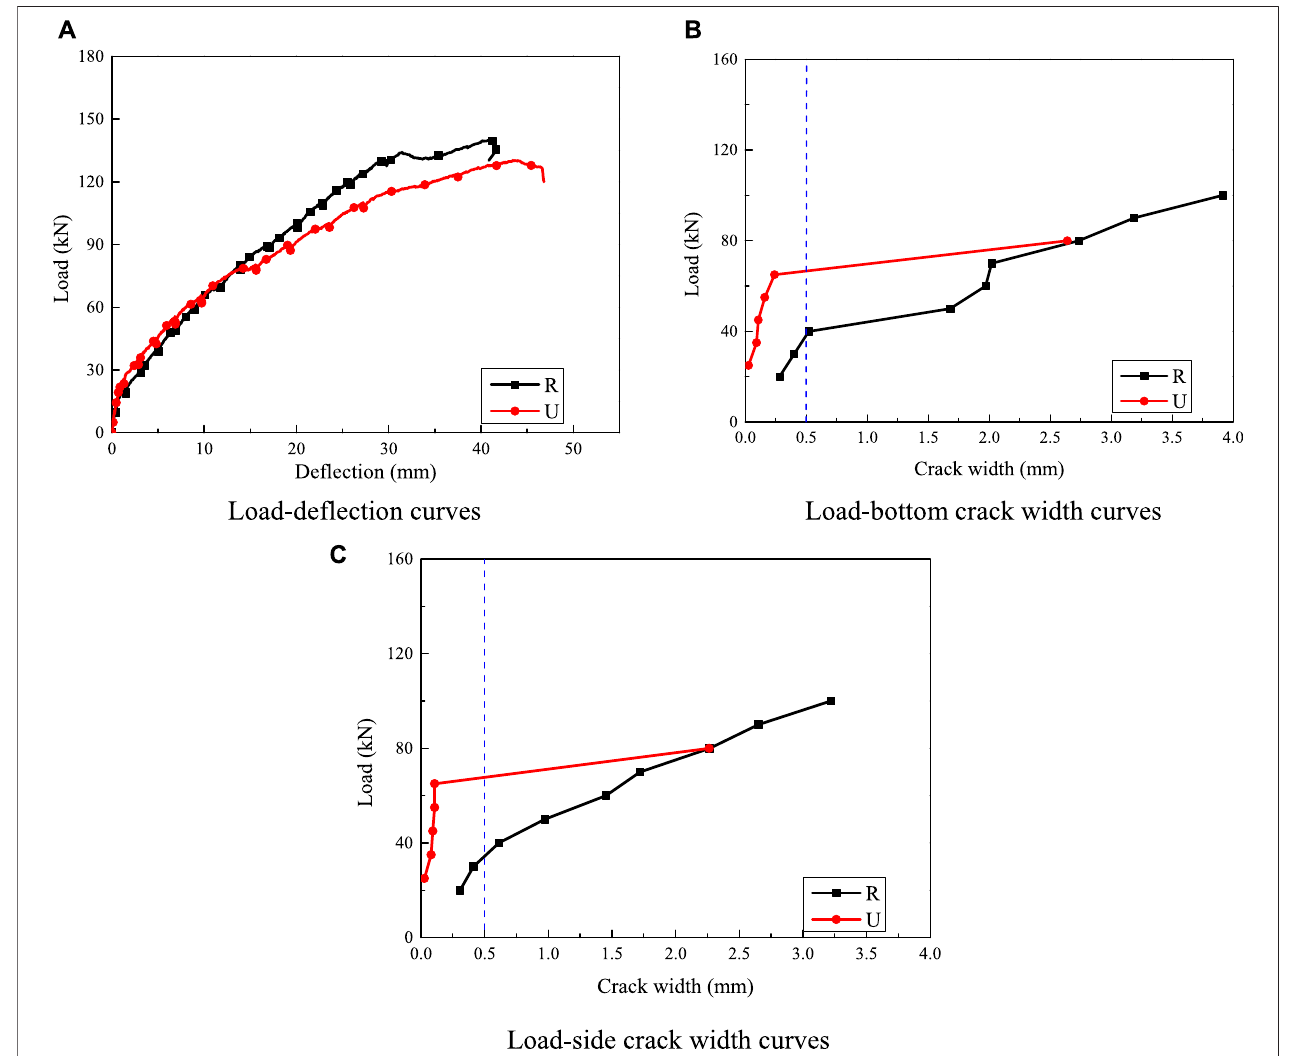
FIGURE 10 | Effect of the existence of U-shaped ECC